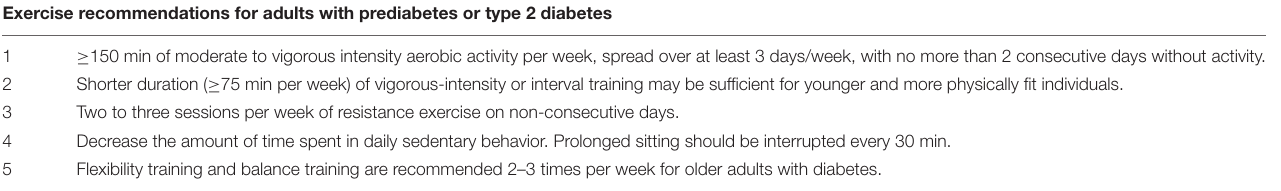
TABLE 2 | Exercise recommendations for adults with prediabetes or type 2 diabetes, issued in American Diabetes Association (2018b) standard of care update. Exercise recommendations for adults with prediabetes or type 2